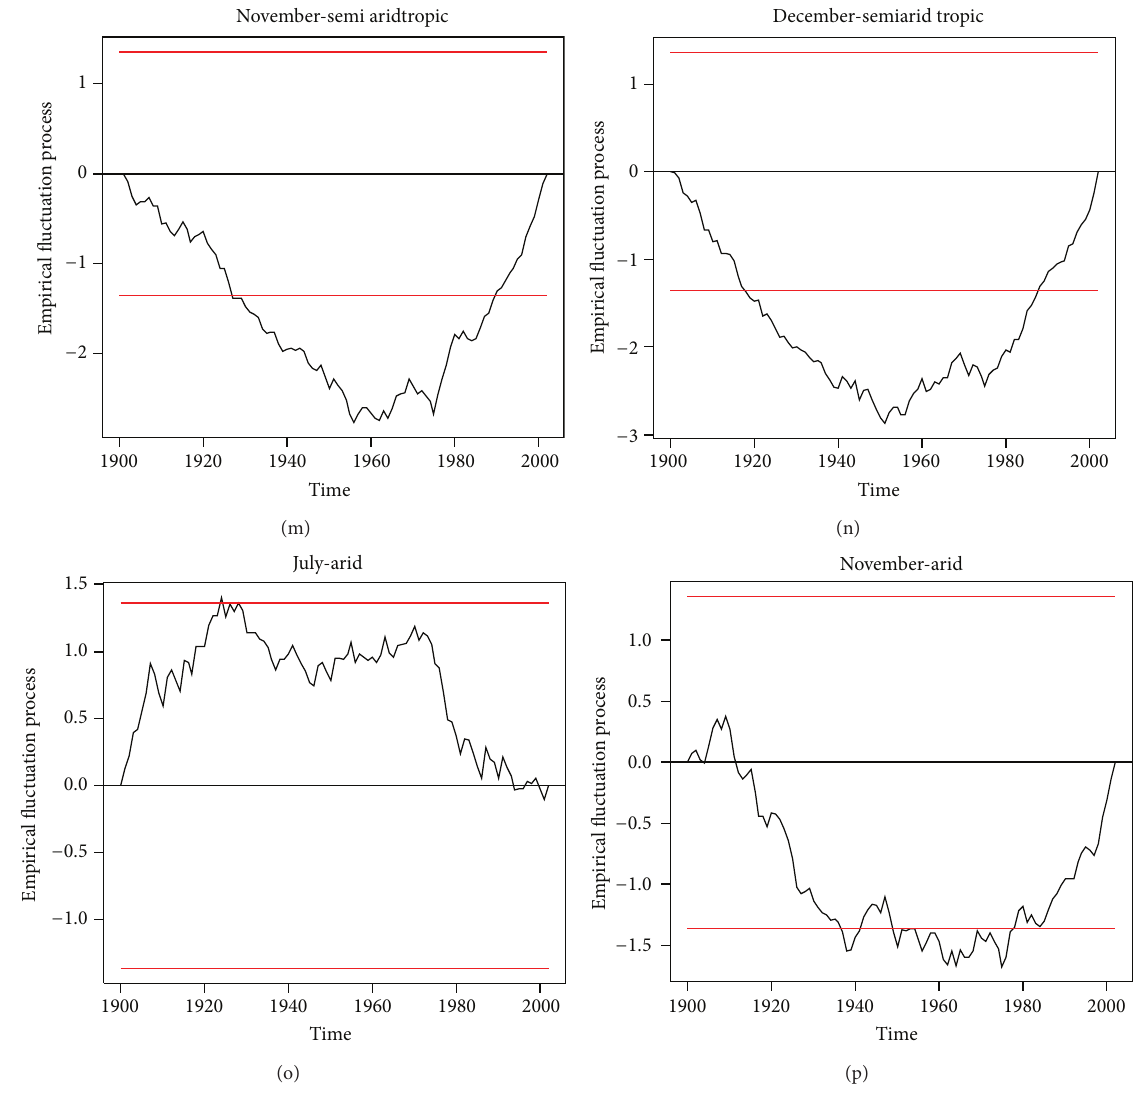
Figure 2: Structural break in monthly average temperature. Table 1: Breaks in annual average